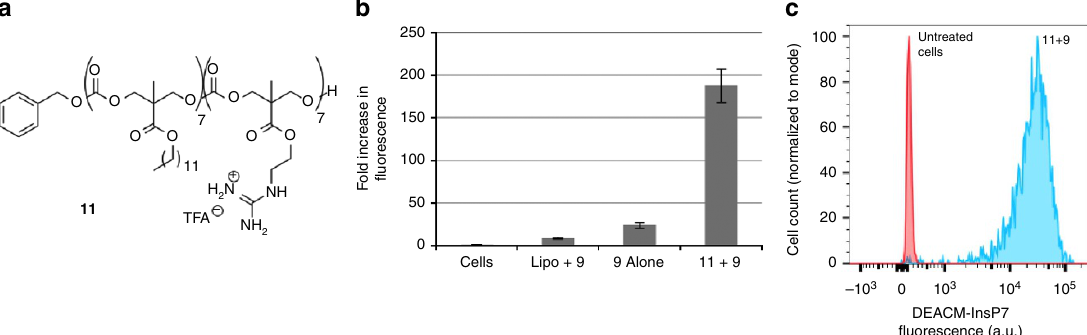
Figure 4 | Intracellular delivery of photocaged 5-InsP 7 to HeLa cells with a guanidinium-rich transporter. ( a ) Structure of amphipathic oligocarbonate transporter, 11 . ( b ) Cellular uptake of 9 as determined by flow cytometry. Complexes were formulated at a 1:1 mole ratio of 9 (5 m M) to 11 . Values reported are normalized to the autofluorescence of untreated cells. ( c ) Histogram plot of intracellular fluorescence demonstrates 4 99% delivery efficiency to